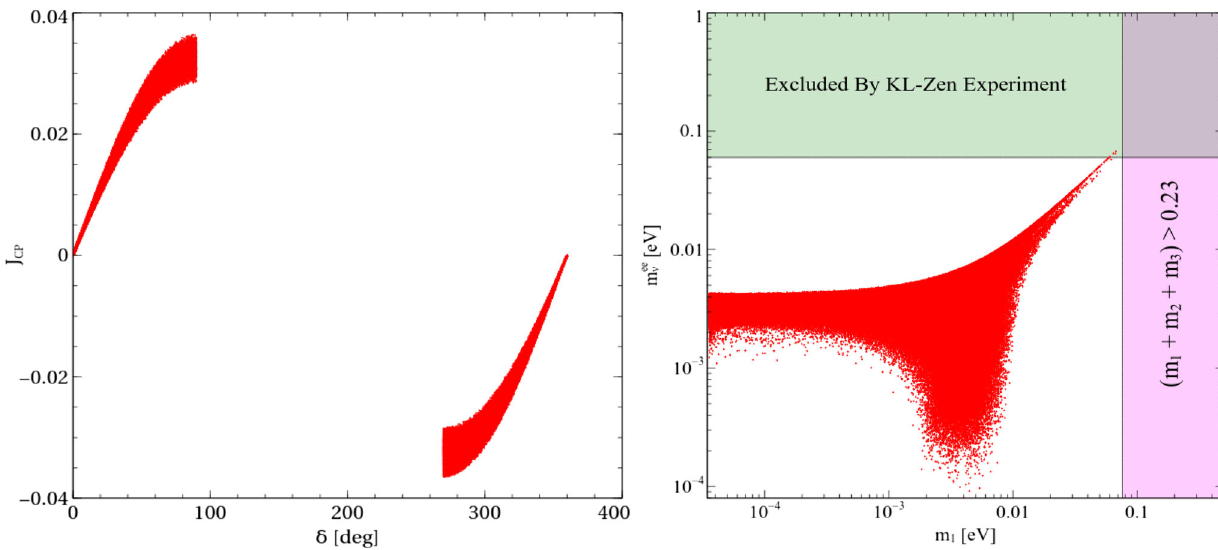
Fig. 1 Left panel: Variation of J cp with δ . Right panel: Variation of neutrino-less double β decay parameter m ββ with m